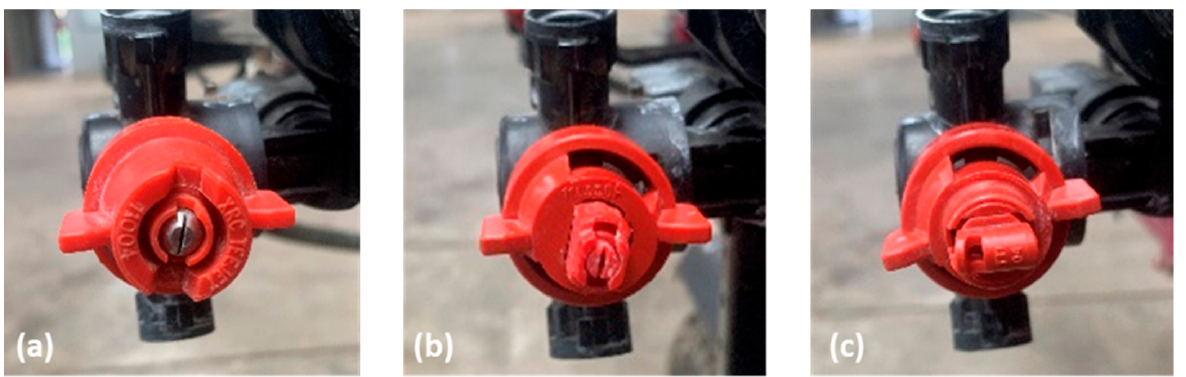
Figure 2. Three different nozzle types: TeeJet ® ( a ) XRC 11004; ( b ) AIXR 11004; and ( c ) TTI 11,004. These nozzle types were used to attain medium, very coarse, and ultra-coarse spray droplets, respectively, [16] in this study.